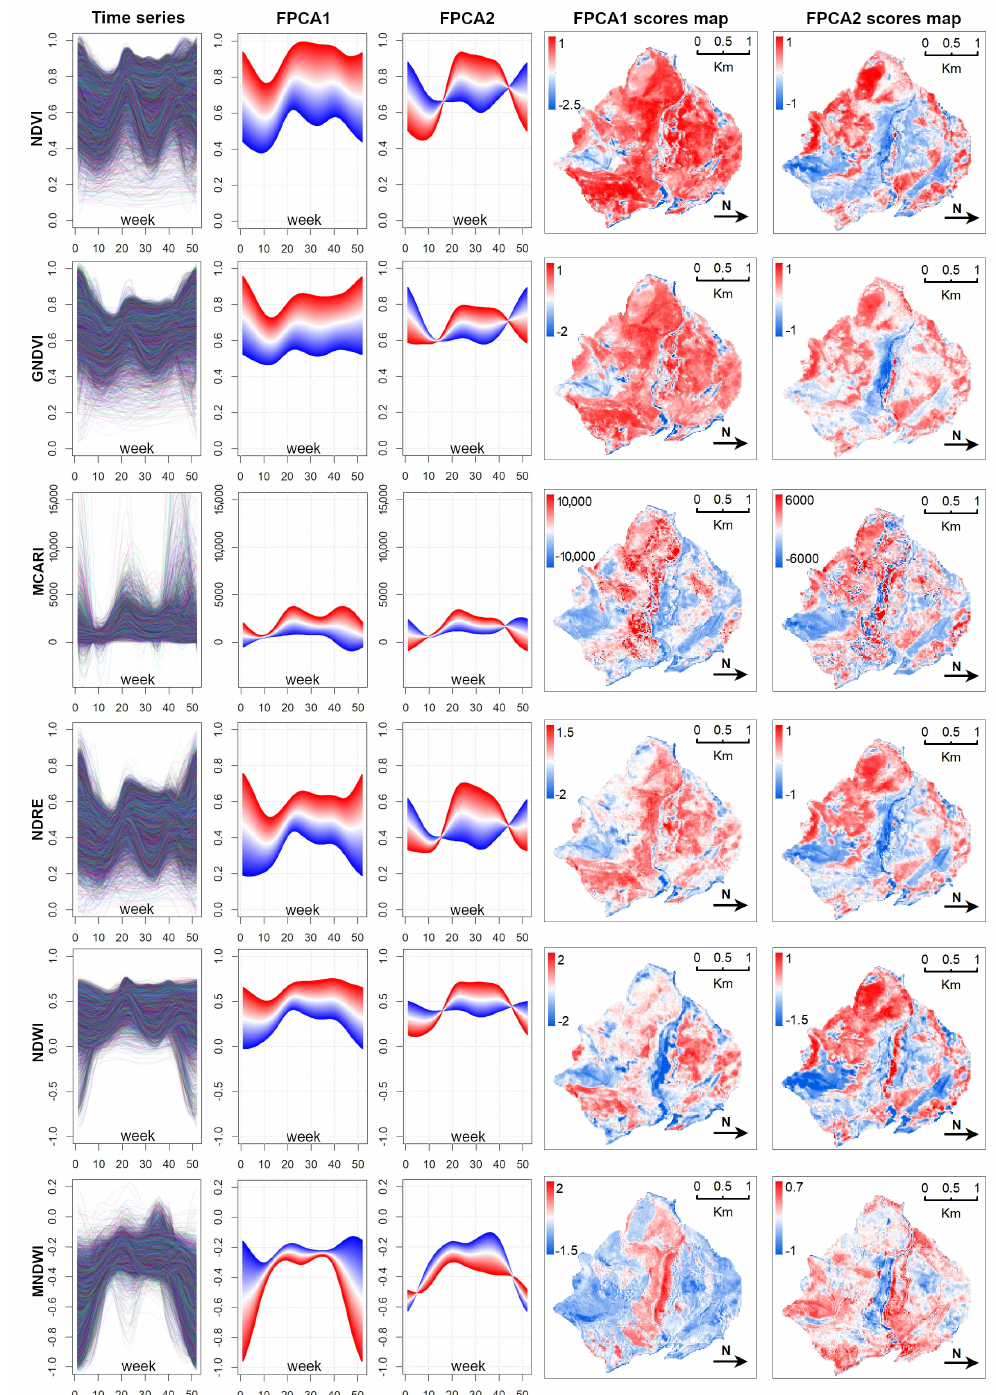
Figure A2. Spatiotemporal pattern of mean seasonal spectral variations, extracted by FPCA from the Sentinel-2 dense time-series. The first column shows the six vegetation index time-series (18,631 pixel- based time-series). FPCA considering a single time-series as a single object of analysis (as a function), and identifies main contrasting modes of variation during the year between the functions (second and third columns) and the respective spatial patterns according to the FPCA scores (fourth and fifth columns). Only the first two components are shown in this figure, for illustrative